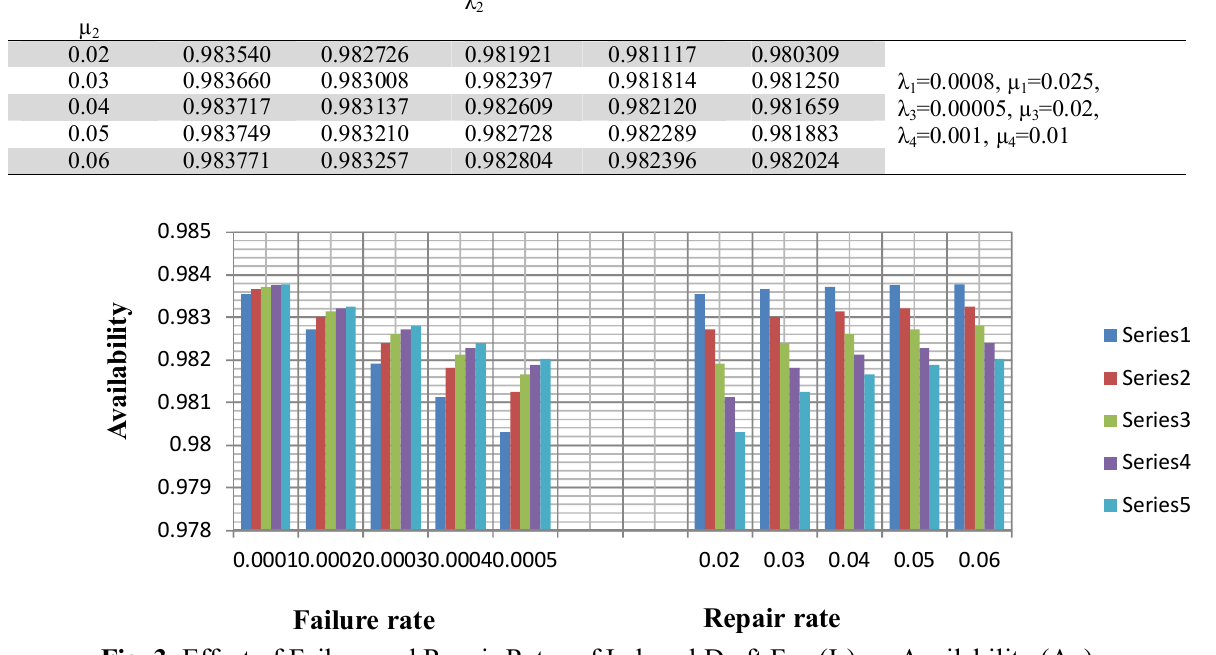
Fig. 3. Effect of Failure and Repair Rates of Induced Draft Fan (I Effect of Failure and Repair Rates of Forced Draft Fan on Availability (A